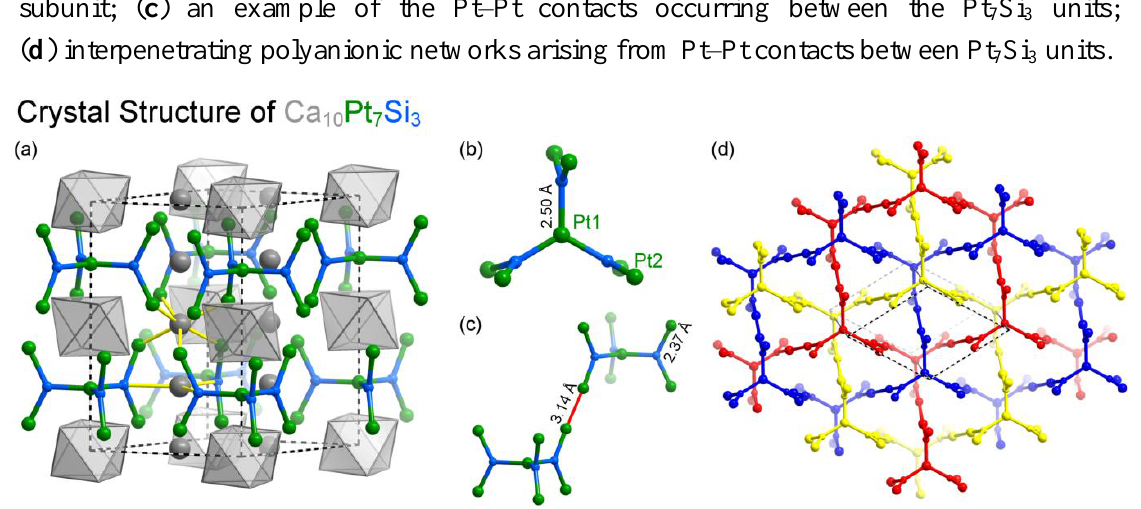
Figure 1. The crystal structure of Ca subunit; ( c ) an example of the Pt–Pt contacts occurring between the Pt ( d ) interpenetrating polyanionic networks arising from Pt–Pt contacts between Pt